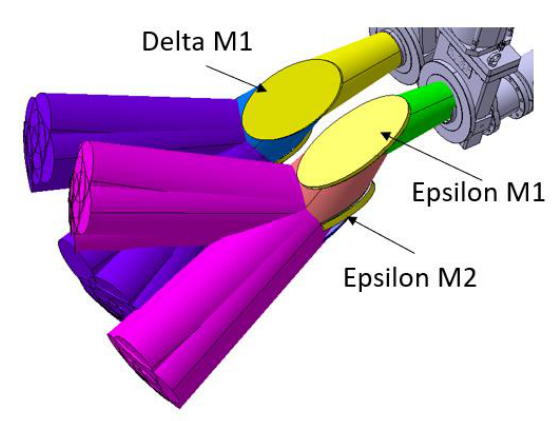
Fig. 3. CAD model of on-axis launcher showing the two beams, and a range of output beams in the co and counter plasma current directions, and for a range of plasma